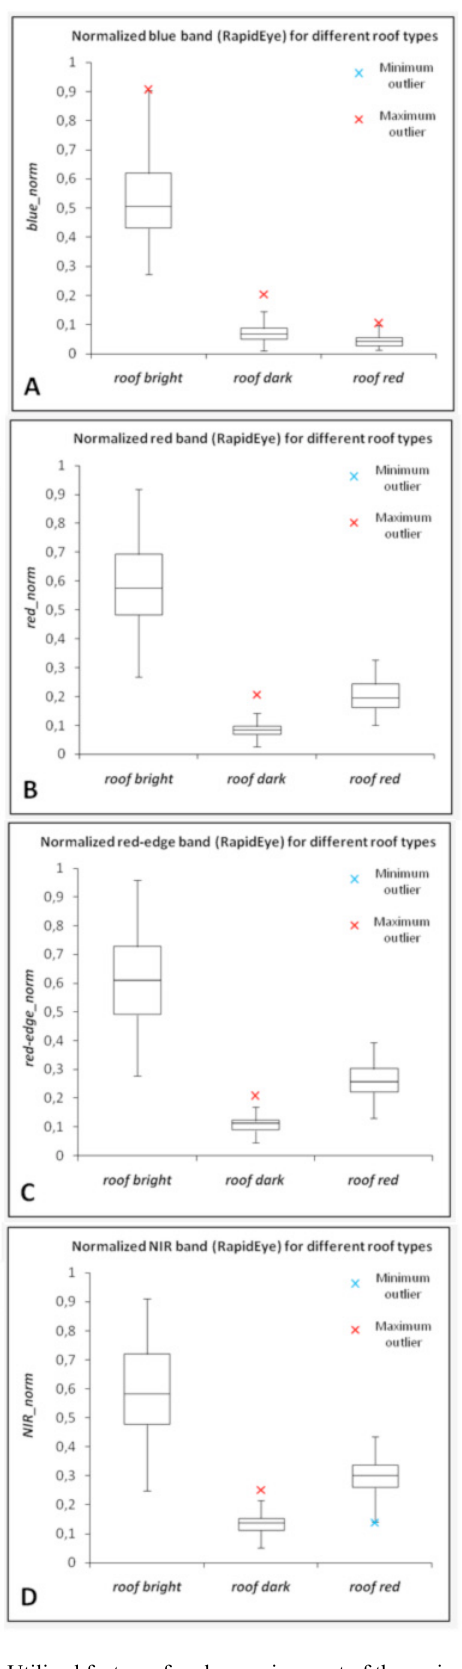
Fig. 3: Urban land use structure classification for a study area in the city of